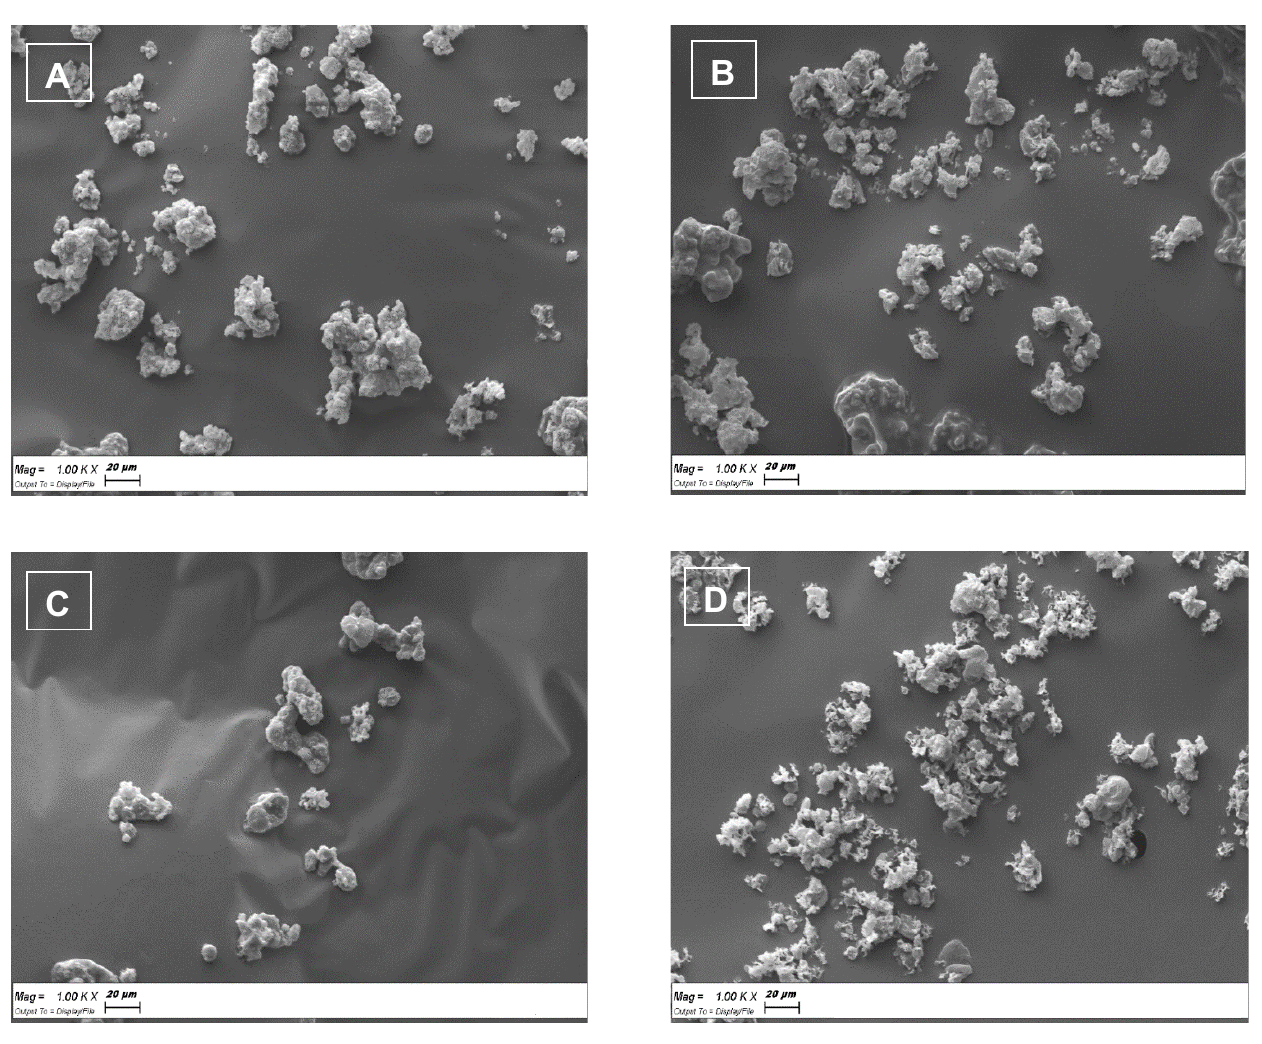
Figure 5. Scanning electron microscopy (SEM) micrographs of the SLMs based on tristearin or stearic acid. ( A ) Tristearin SLMs loaded with Fer; ( B ) Stearic acid SLMs loaded with Fer; ( C ) Tristearin SLMs loaded with Fer-Me; ( D ) Stearic acid SLMs loaded with Fer-Me. Table 1. Loading parameters of SLMs obtained through hot emulsion